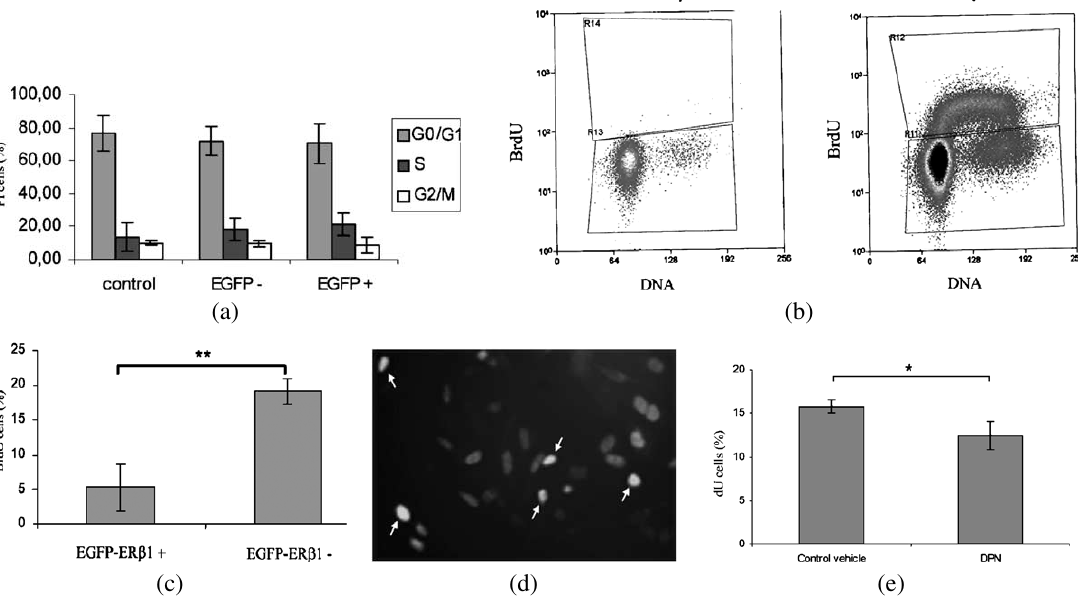
Fig. 6. Effects of ER β 1 over-expression and DPN administration on cell cycle distribution. (a) Flow cytometric analysis of propidium iodide stained LNCaP cells showed that the transfection of an empty vector (EGFP + ) did not significantly change the cell cycle distribution as compared to non-transfected cells (EGFP–) of the same culture dish, and to control cells. (b, c and d) LNCaP cells transfected with an EGFP-ER β 1 vector, labeled with BrdU, and analyzed by flow cytometry (b and c) and immunofluorescence (d) showed that ER β over-expression significantly decreased the percentage of BrdU labeled cells (b, left image and c) compared to non-transfected cells of the same culture dish (b, right image). The majority of LNCaP cells over-expressing ER β 1 (white cells, labeled with arrows) were negative for BrdU immunolabeling (gray cells) and vice-versa (d). The administration of 10 − 6 M DPN for 72 h showed a significant decrease in BrdU incorporation (e). ∗∗ p (cid:2) 0 . 01, ∗ p (cid:2) 0 .